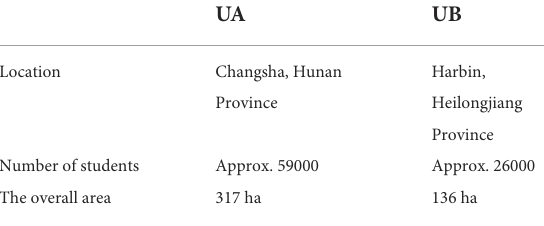
TABLE 2 Characteristics of the universities in this